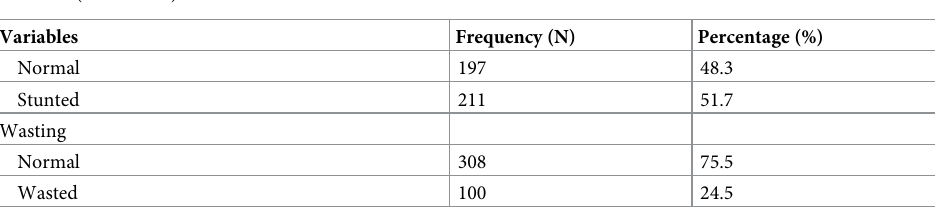
PLOS ONE | https://doi.org/10.1371/journal.pone.0239013 September 15,